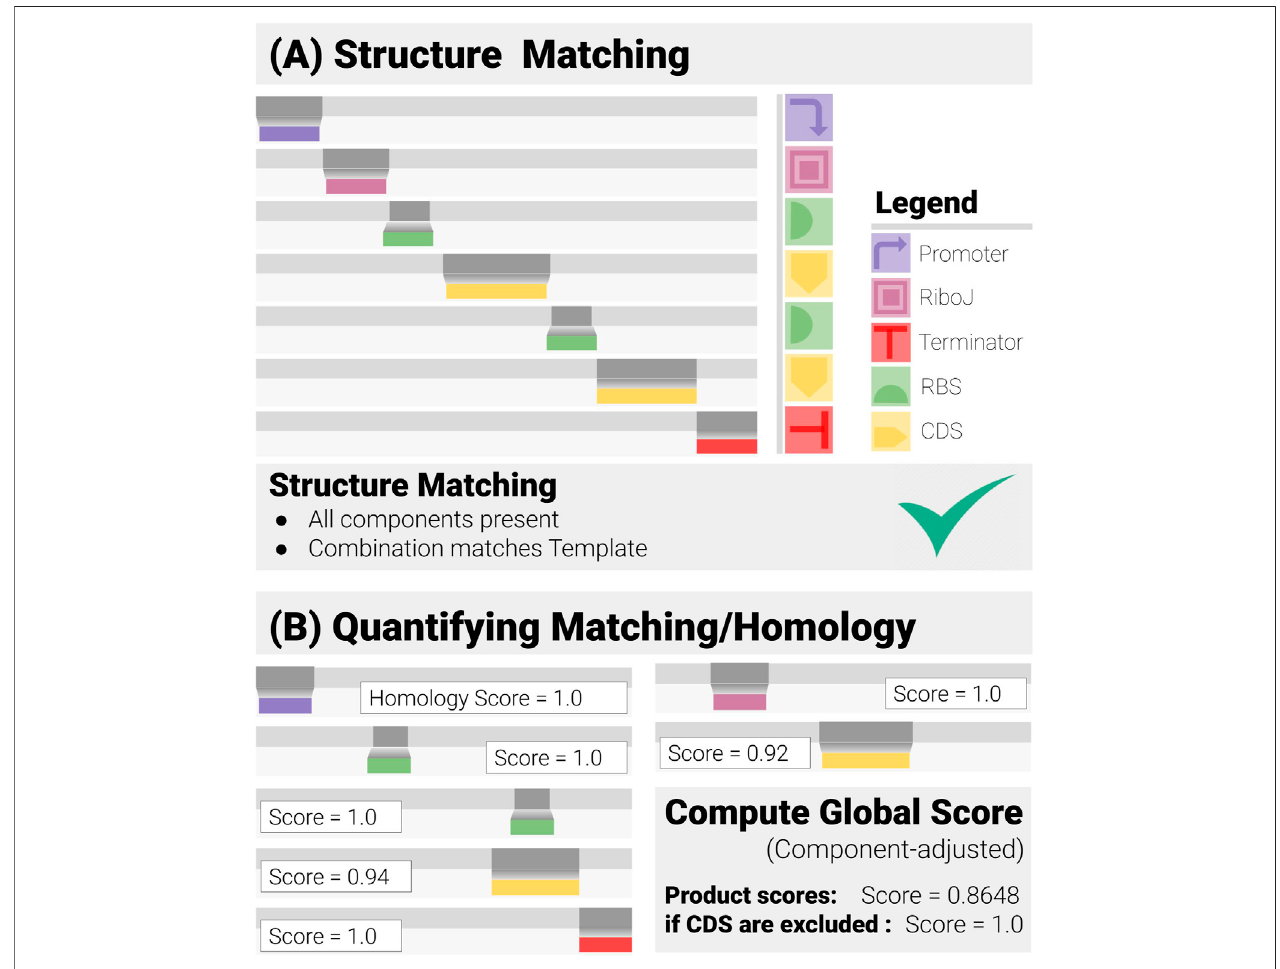
FIGURE 2 | Construct Matching in Action (for a Two-gene Operon Design). Construct-matching performs two complementary tasks. (A) Structure Matching: this step and checks whether the data correspond to an admissible construct, that is contains all the speci fi ed components in a combination that matches the design template. (B) Quanti fi cation of the Matching: each component has its own matching/homology score, from which a global score is